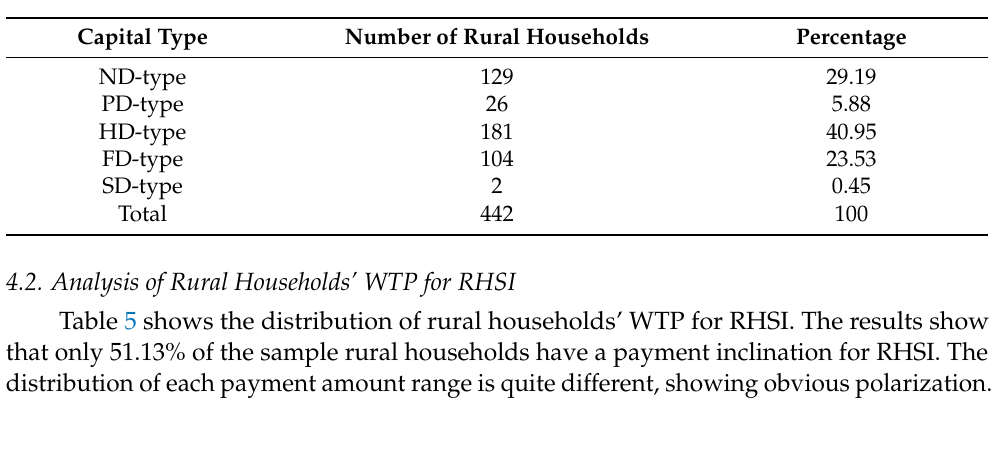
Table 4. Livelihood capital structure of rural